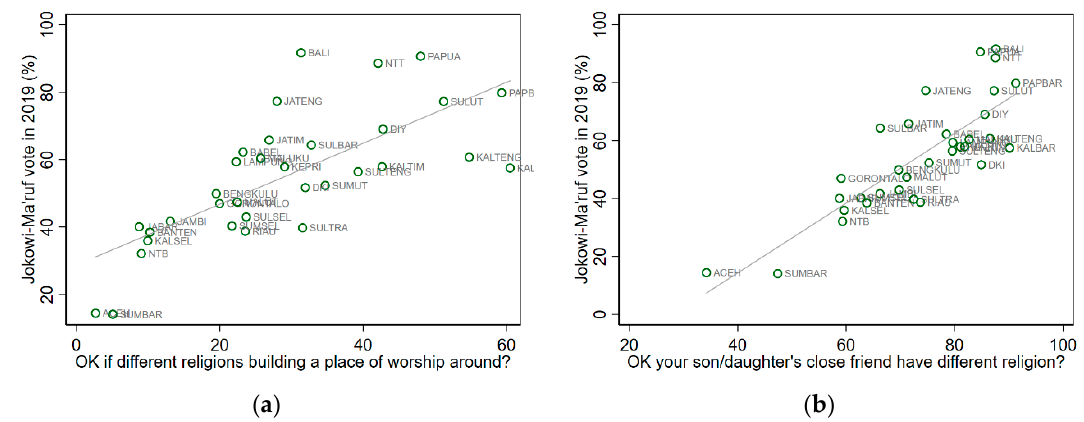
Figure 2. ( a ) Cross-province association between Jokowi/Ma’ruf vote in 2019 election (%) and percentage of population who do not object a place of worship of different religion being built in their neighborhood (%); and ( b ) Cross-province association between Jokowi/Ma’ruf vote in 2019 election (%) and percentage of population who do not object to their children having friends of different religions (%). Source: SUSENAS 2014, calculation by author.